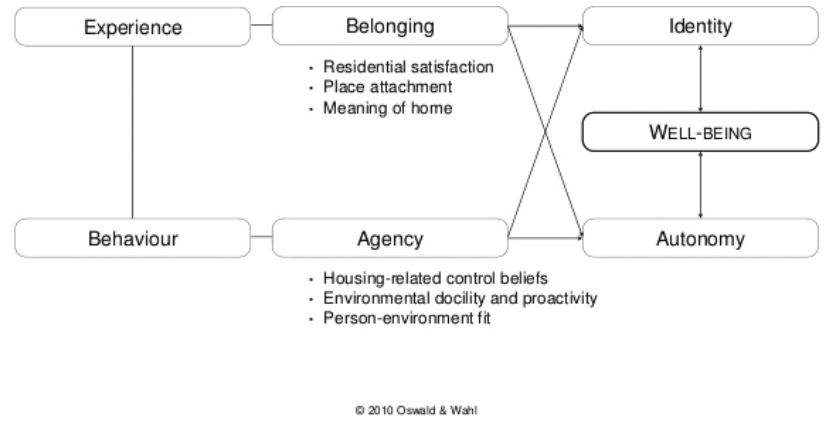
Figure 1. Person–environment fit (Wahl & Oswald